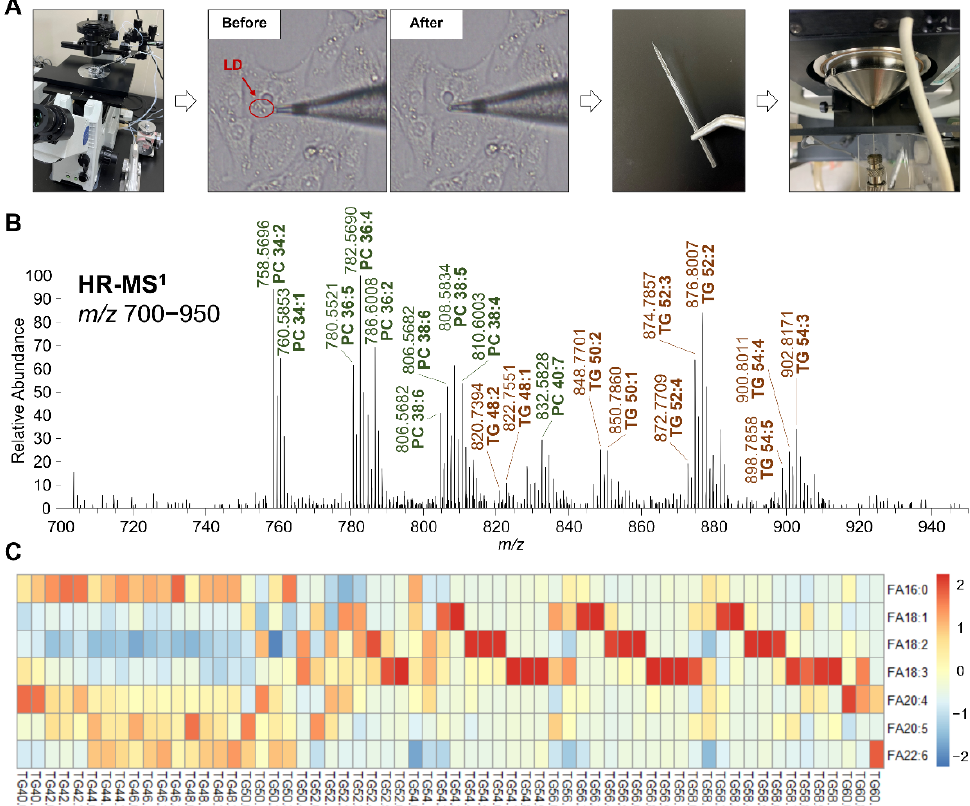
Figure 3. TG profile in LD analyzed using nanoESI − MS. ( A ) Workflow, including the control of glass capillary using 3D manipulator, aspiration of LD from cells, in-tip solvent microextraction, and sample spray into MS. ( B ) Representative high-resolution MS spectrum of LD, within the range from m / z 700 to 950. The representative PC and TG species are shown in green and red, respectively. ( C ) Heatmap of LD TG molecular species composition in the cells treated with different fatty acids.